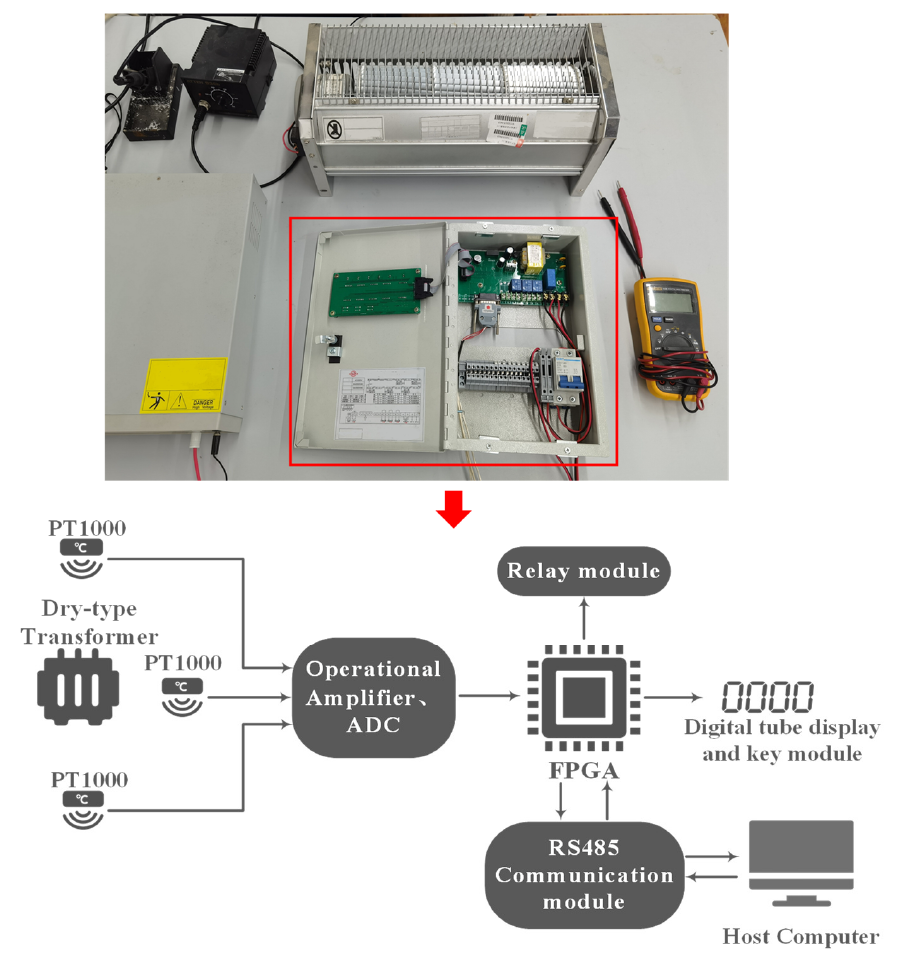
Figure 1. The dry-type transformer temperature monitor and its architecture.